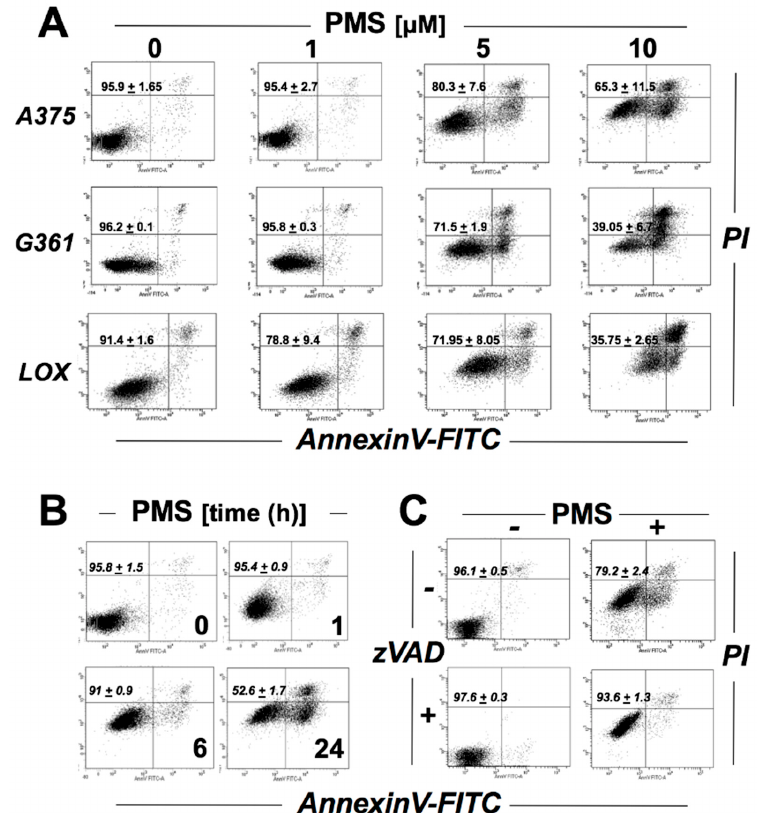
Figure 2. PMS treatment impairs viability of human malignant melanoma cells inducing caspase-dependent cell death. Viability of PMS-exposed cells was monitored using flow